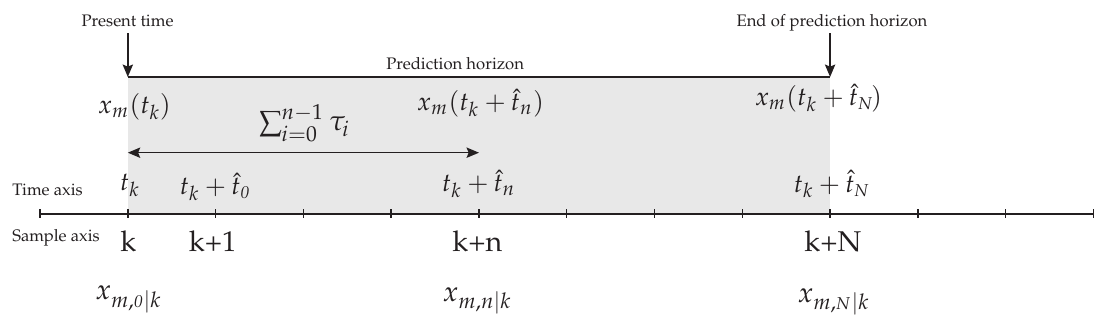
= x m ( t + ˆ t n ) at some future time t k m , n k |